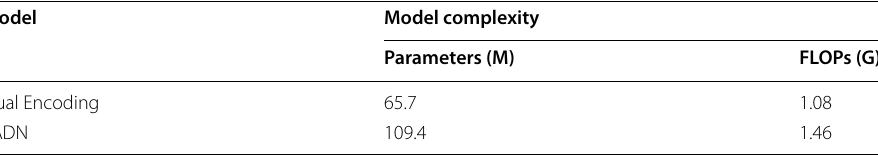
Table 2 Model complexity of Dual Encoding and our model LADN